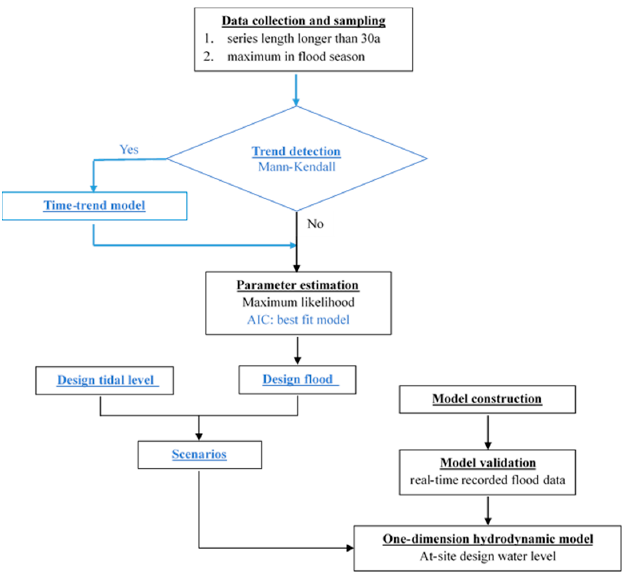
Figure 2. Flow chart of the methodology. Parts highlighted in blue considered non-stationarity in time series.